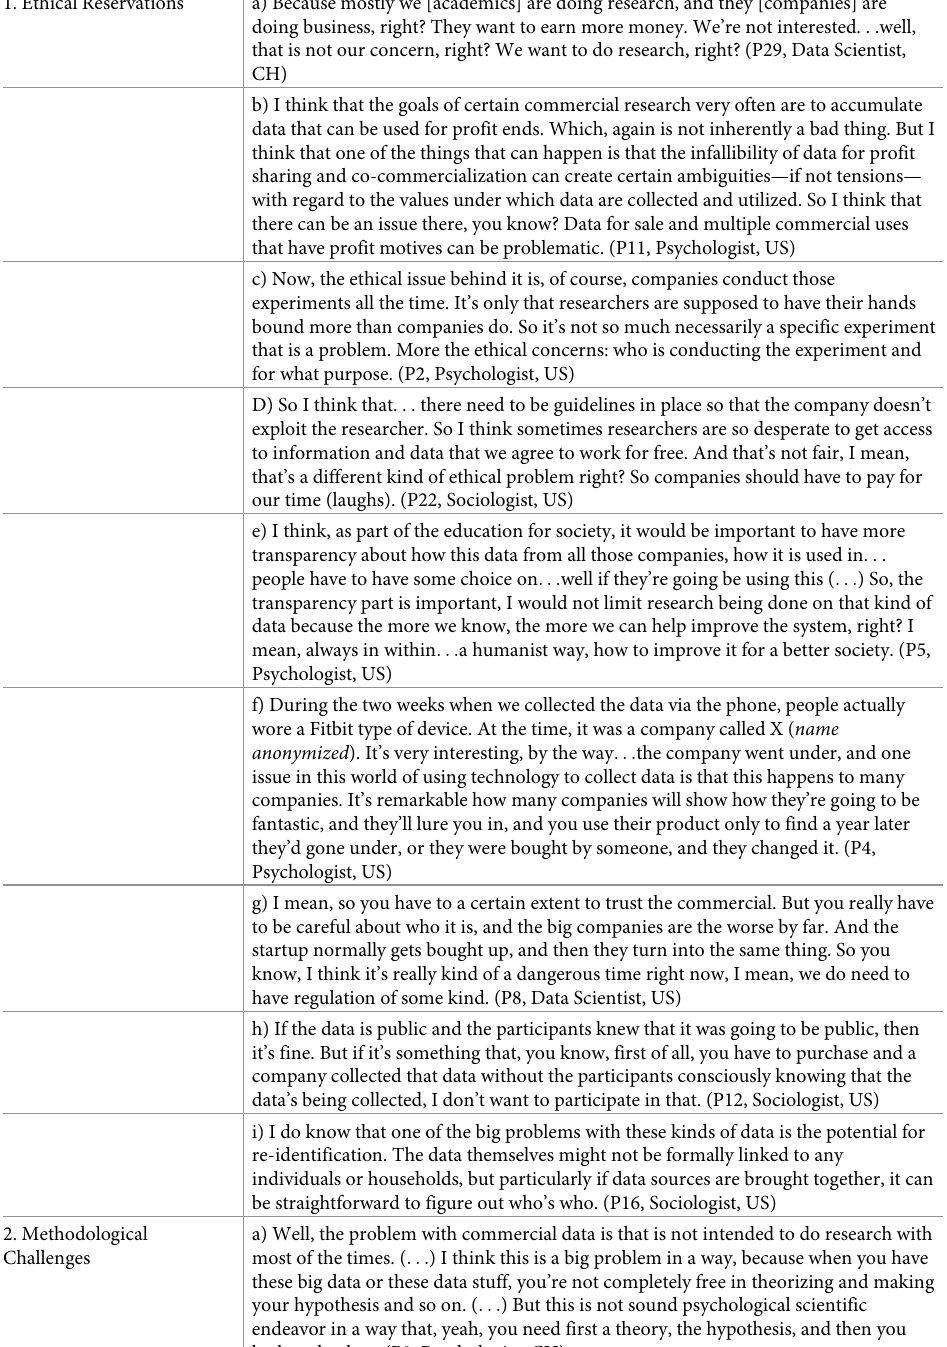
Table 7. Relevant quotes over perceived challenges for corporate